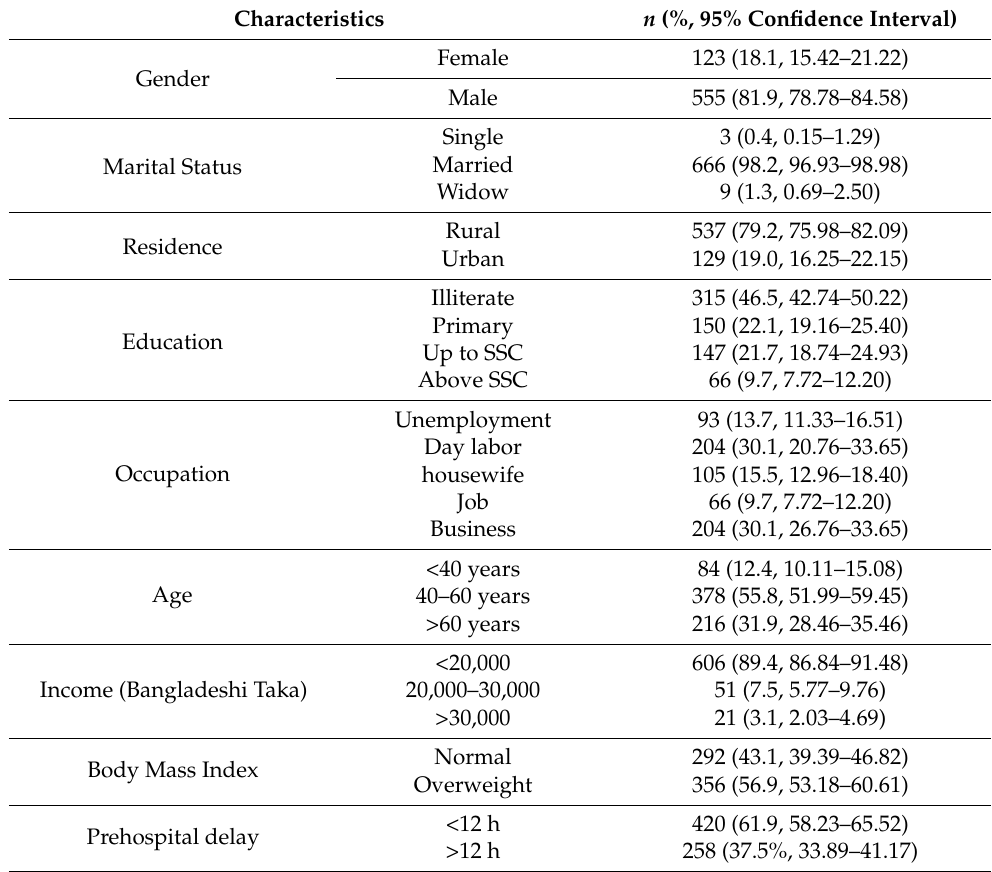
Table 1. Demographic characteristics of the study patients (N = 678).